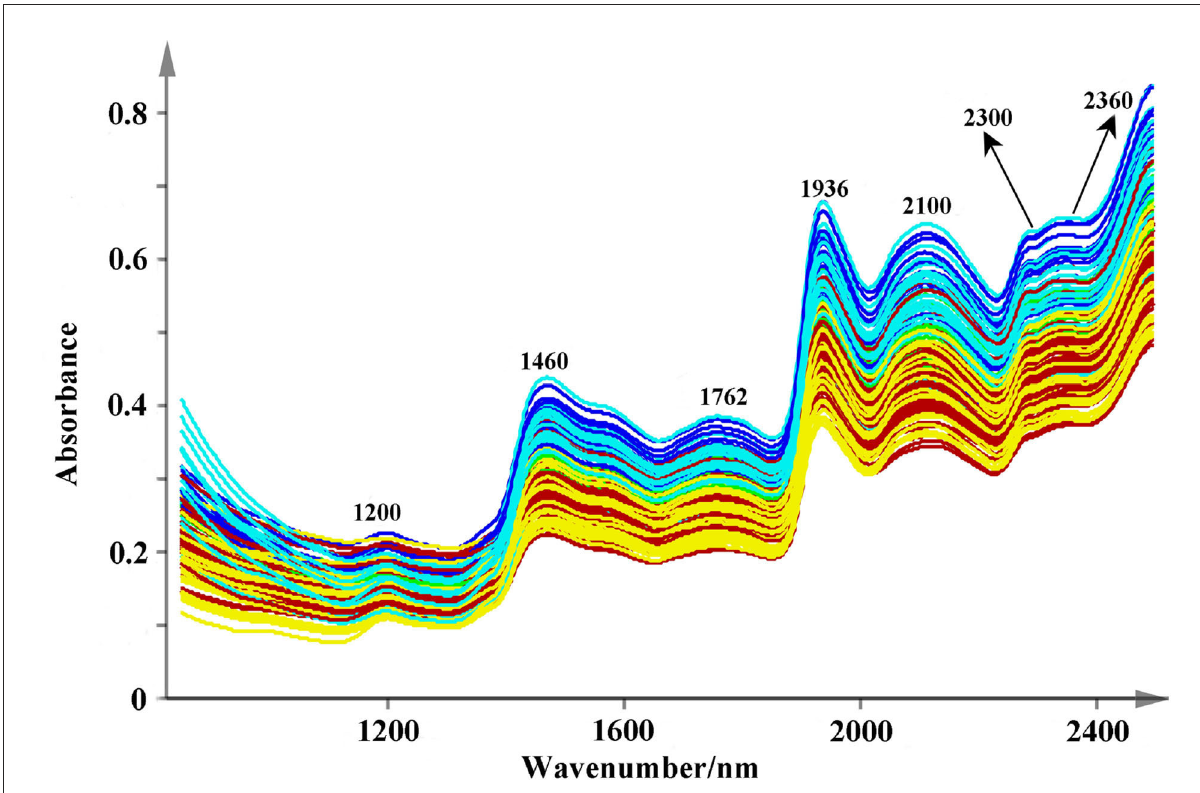
FIGURE4 The raw NIR spectra fingerprints of Salvia medicines (Description: this figure shows the original NIR spectra of different medicines from 850 to 2,500 nm at 2 nm intervals. Several common peaks are also marked in this figure.).